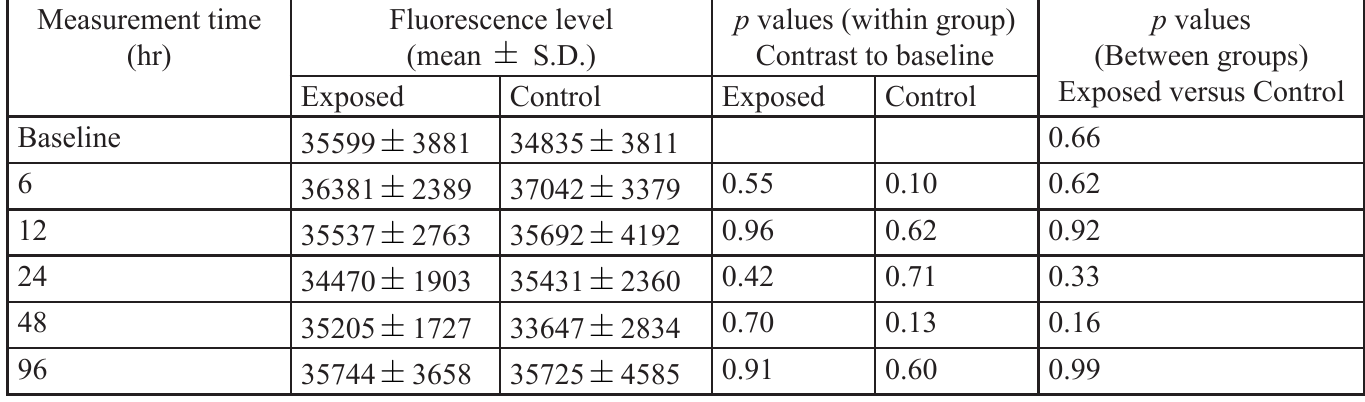
Table 4. Descriptive statistics of the fluorescence data for lenses exposed to COMPLETE multipurpose contact lens solution ( n = 10 for exposed lenses, and n = 10 for control